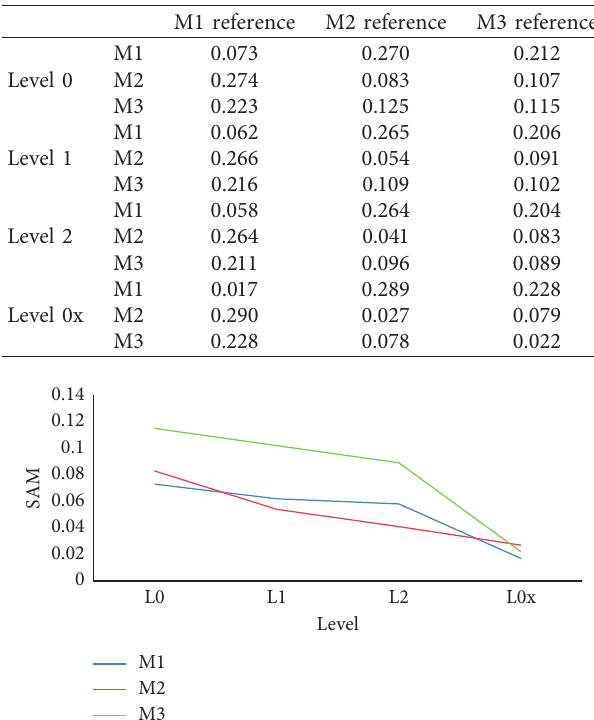
Table 3: Results of SAM using an internal reference which is the average spectrum of each rock type either in laboratory (L3) or in the field (L3x).